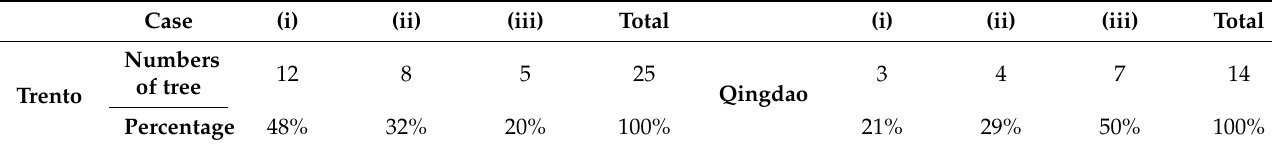
Table 5. Statistics of failure